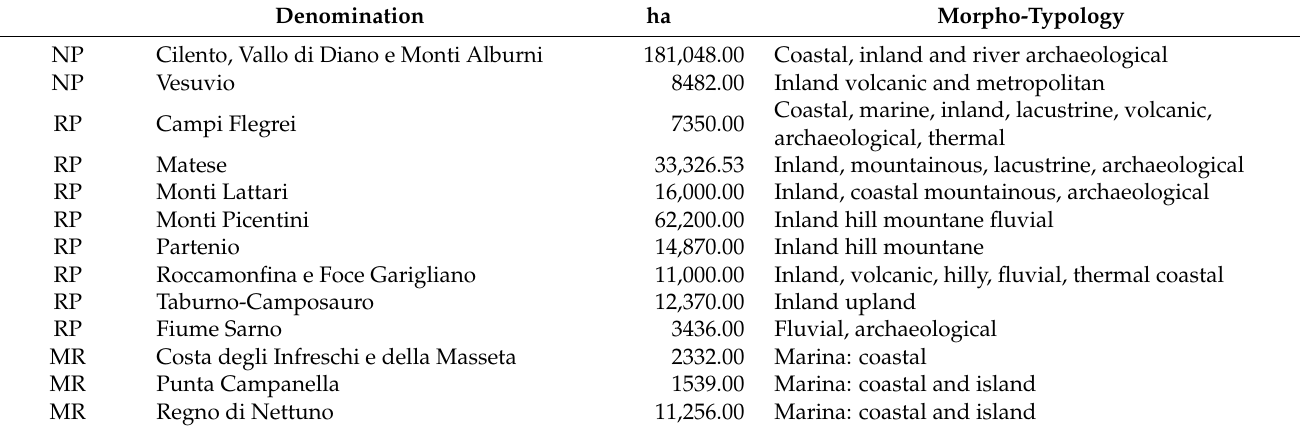
Figure 1. National Parks (in shades of green), Regional Parks (in red), Municipalities of National Parks (in yellow), Municipalities of Regional parks (in pink), with small point, the centre of Park, with continuous black line, park area boundary [7]. Table 2. Natural protected areas of the Campania Region, land area and type (elaboration by Antonio Bertini). Keys: NP, National park; RP, regional park; MR, marine reserve; UAP Underwater archaeological park; SR, State reserve; RR, Regional reserve; RUP, Regional Urban Park; OPA, Other protected